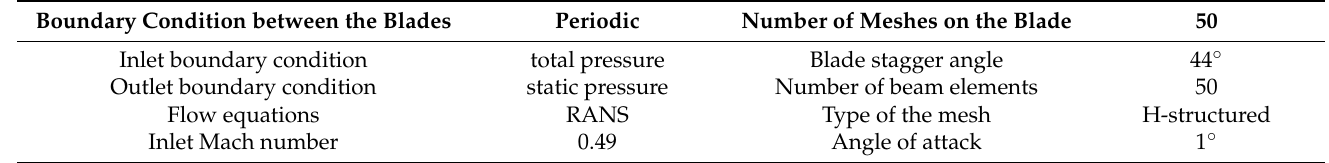
Table 1. Solution and boundary conditions of flow passing over the blades using the UESA. Boundary Condition between the Blades Periodic Number of Meshes on the Blade 50 Inlet boundary condition total pressure Blade stagger angle 44 ◦ Outlet boundary condition static pressure Number of beam elements 50 Flow equations RANS Type of the mesh H-structured Inlet Mach number 0.49 Angle of attack 1